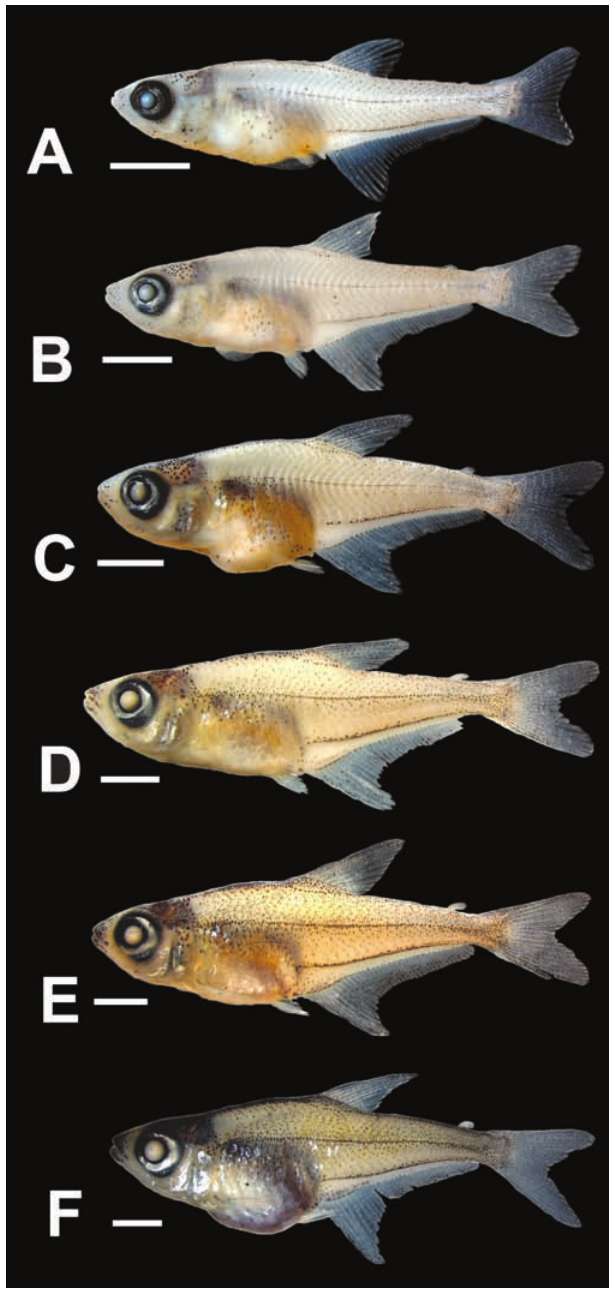
Fig. 5. Larvae of Heterocharax macrolepis , lateral view. A: 9.3 mm SL; B: 10.2 mm SL; C: 13.6 mm SL; D: 15.5 mm SL; E: 16.2 mm SL; F: 18.6 mm SL. Scale bar: 2